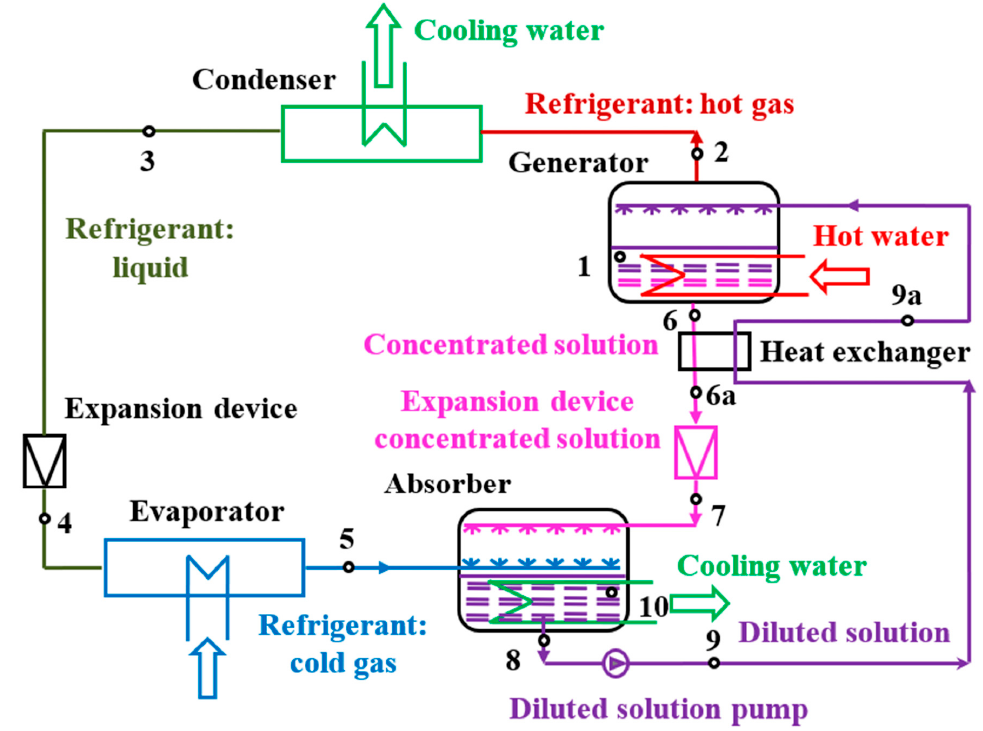
Figure 4. The principle scheme of the LiBr-H 2 O solar absorption chiller.